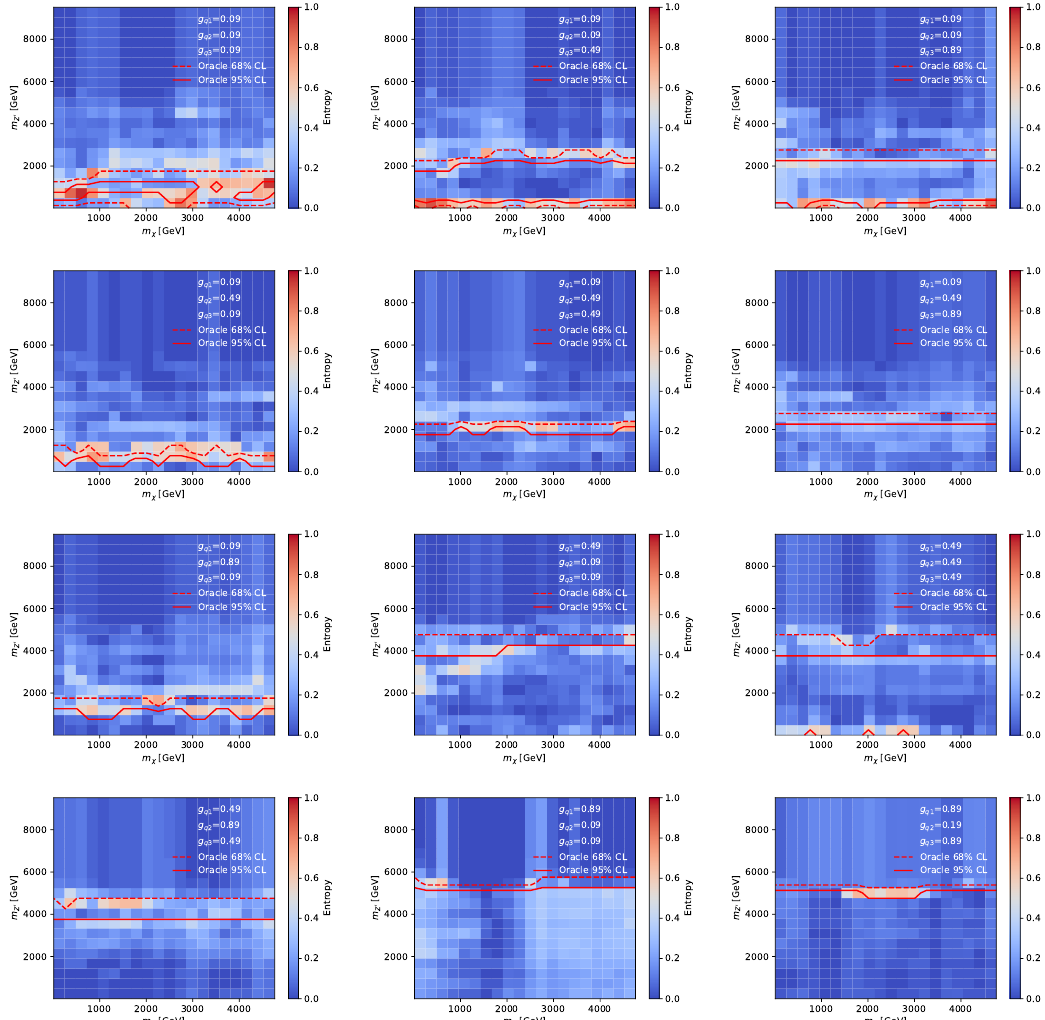
Figure 7: Examples of O RACLE exclusion contours extracted from 13 TeV LHC measure- ments, in slices of the parameter space of a simplified DM model with five free parame- ters. The testing pool recall, precision and entropy were 0.9, 0.92 and 0.11 respectively, after sampling only 6.3% of the total grid size. The results are presented as a function of the dark matter mass ( m χ ) versus vector mediator mass ( m couplings of the vector mediator to the three generations of SM quarks, g The colour scale shows the entropy for the prediction at each point, which is a measure of the uncertainty of the prediction: higher values indicate regions where the prediction is more uncertain. The red dashed and solid lines represent the 68% and 95% exclusion contours predicted by the O RACLE